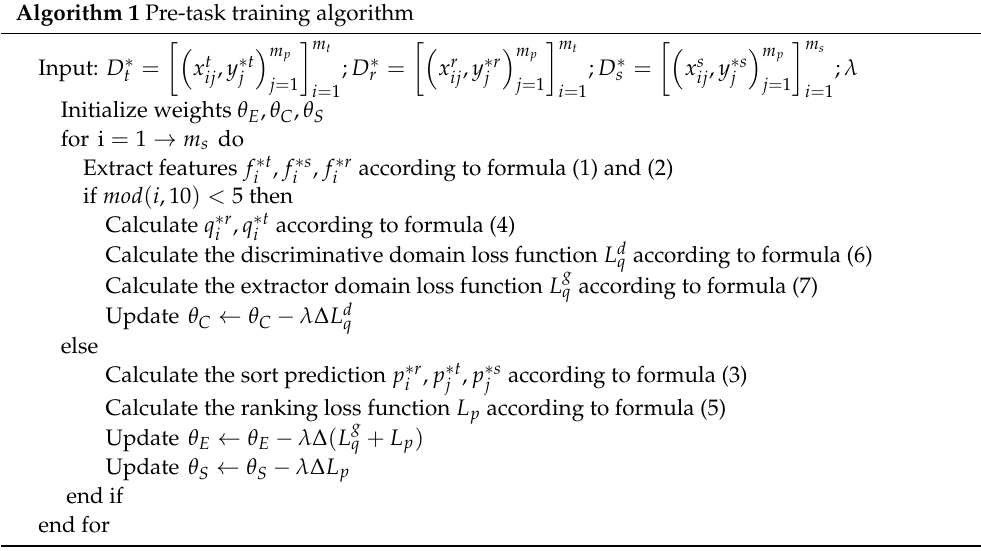
Algorithm 1 Pre-task training